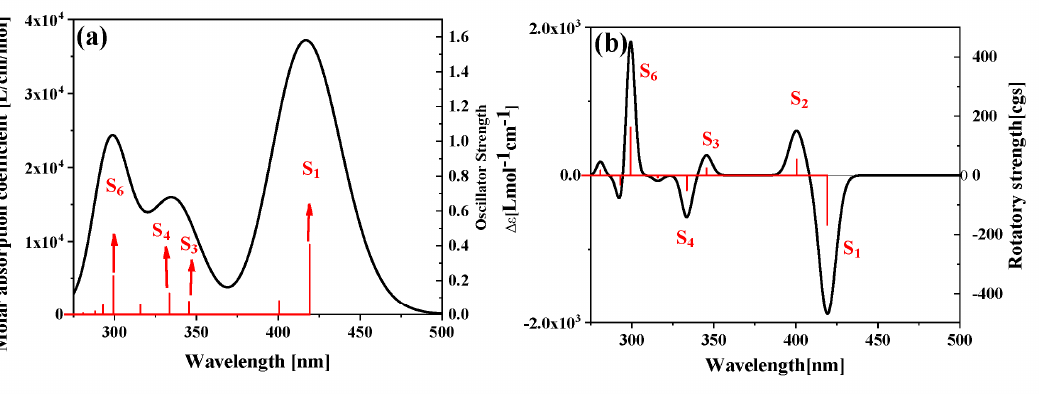
Figure 2. The one-photon absorption spectrum ( a ) and electron circular dichroism (ECD) spectrum ( b ) of PM567 dyes.